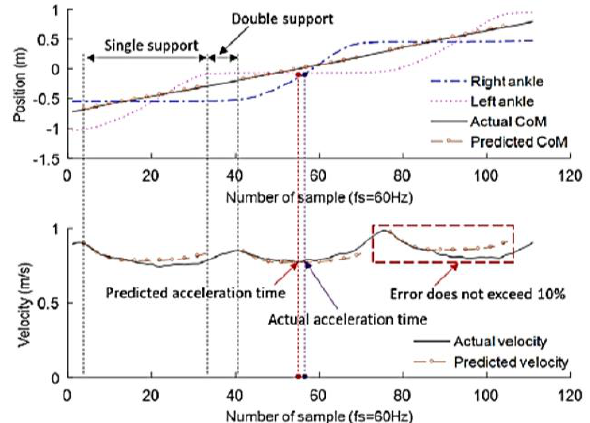
Figure 4. The predicted and real state of CoM.